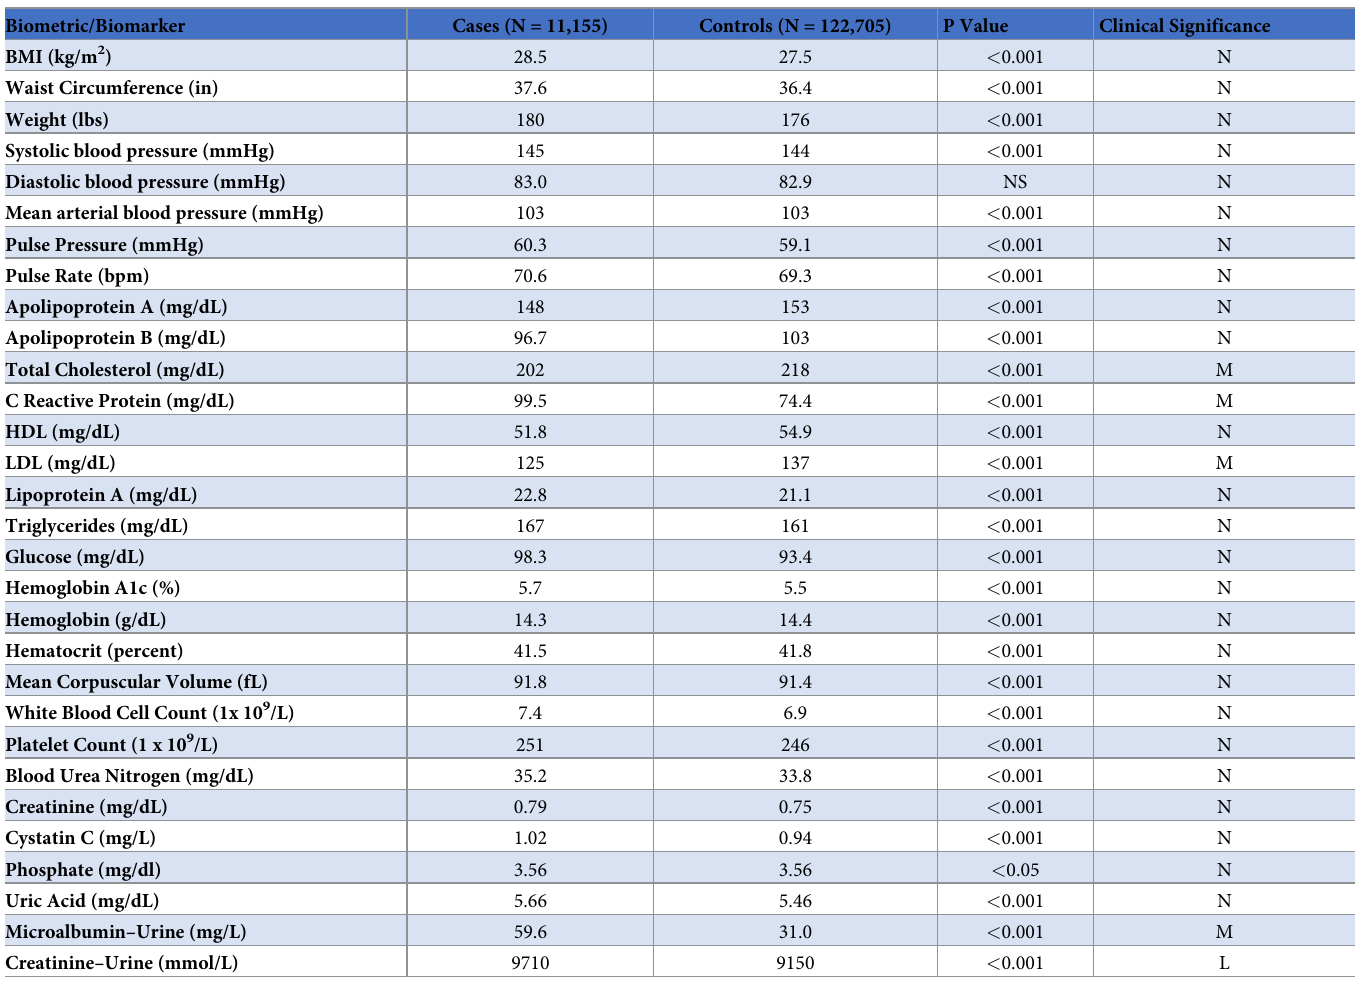
Table 3. Relevant biometrics and biomarkers of cases and controls.